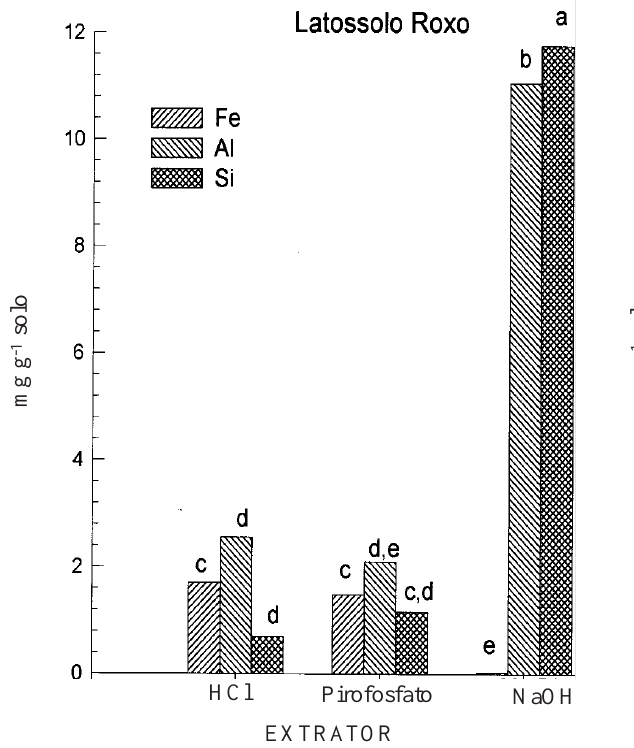
Figura 1. Teores de Fe, Al e Si, determinados nos ex- tratos de HCl 0,5 mol L -1 , pirofosfato 0,15 mol L -1 (pH 7) e NaOH 0,5 mol L -1 do método 2, no LR. Letras minúsculas diferenciam médias, pelo teste de Duncan a 5%, para cada elemento em todas as três amostras das figuras 1, 2 e 3.